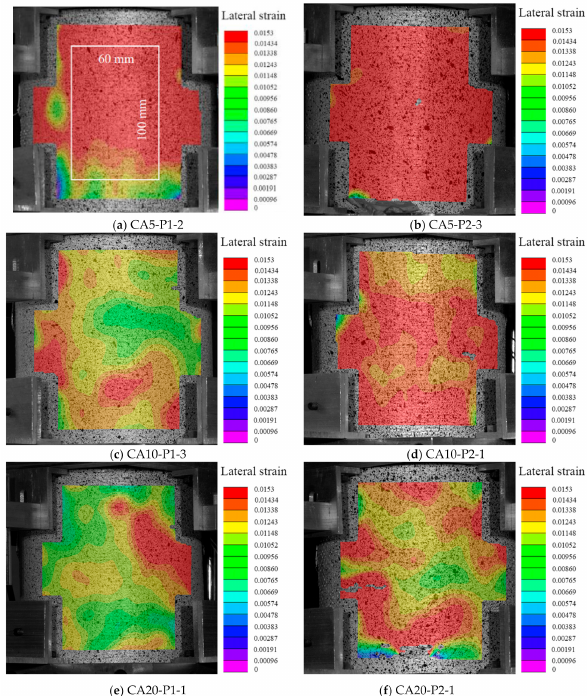
Figure 6. Lateral strain distributions.